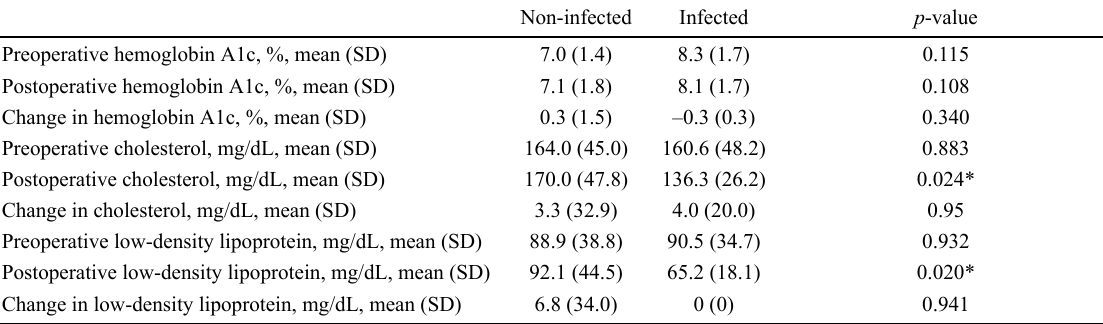
Fig. 1. Wound culture bacterial growth of infected patients after IPP placement. MRSA, Methicillin-Resistant Staphylococcus Aureus. Table 2. Patient pre- and post-operative lab